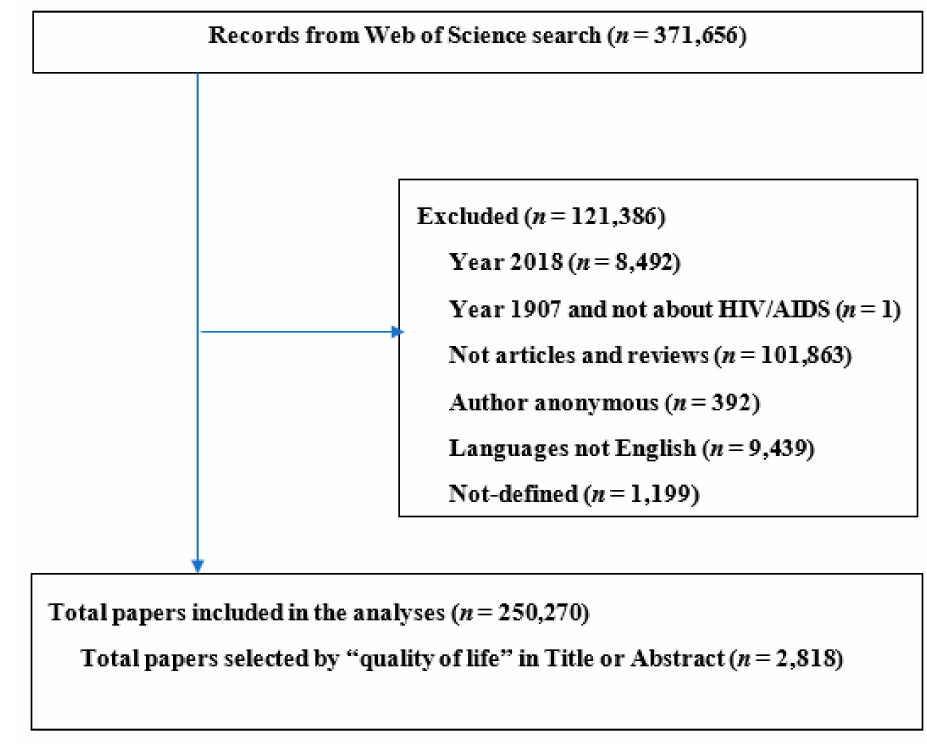
Figure A1. Selection of papers. The searching and paper selection process identified 250,270 related to HIV / AIDS. Among those, 2818 papers included the terms “quality of